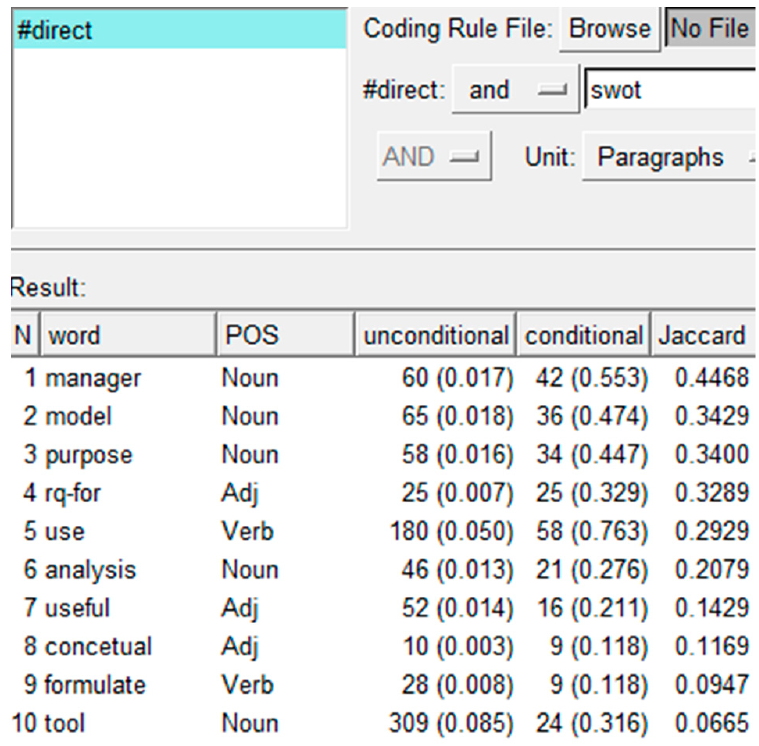
Figure 8. SWOT word association.